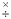
Four satellite-derived estimates for the zonal geometric mean surface chlorophyll a biomass (÷×1 geometric standard deviation) in (a) picoplankton, (b) nanoplankton, and (c) microplankton size classes.